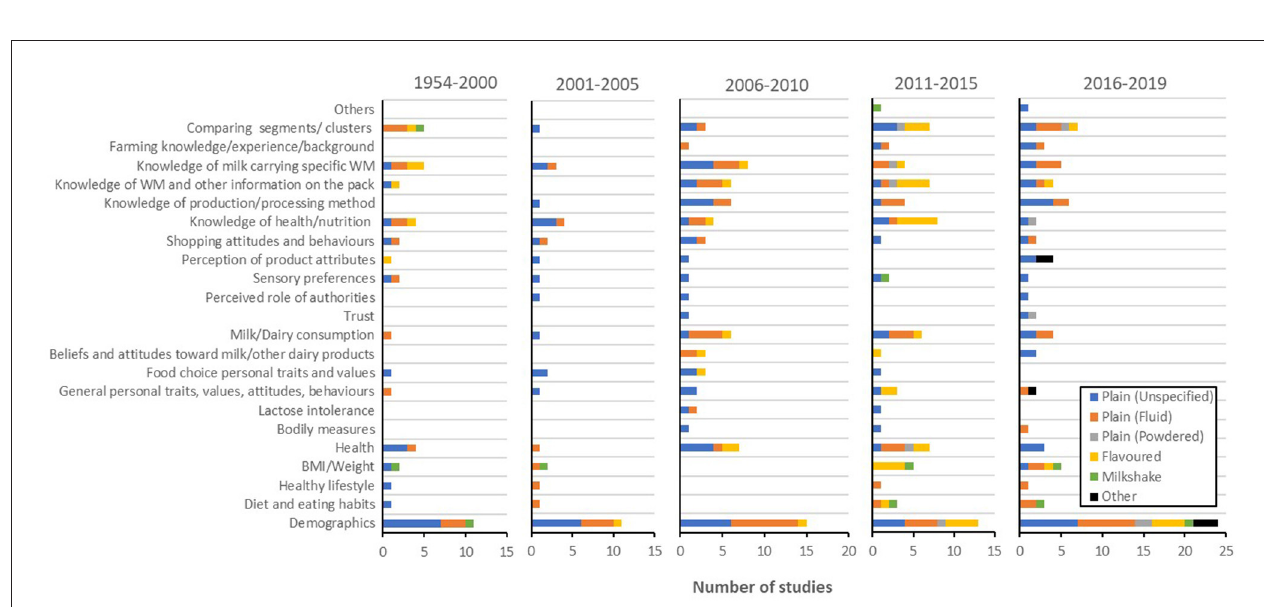
FIGURE 10 | Prevalence of sender-related empirical studies for each milk type [i.e., plain (unspecified), plain (fluid), plain (powdered), flavoured milk, milkshake, and other milk drinks] during each period (i.e., 1954–2000, 2001–2005, 2006–2010, 2011–2015, and 2016–2019).